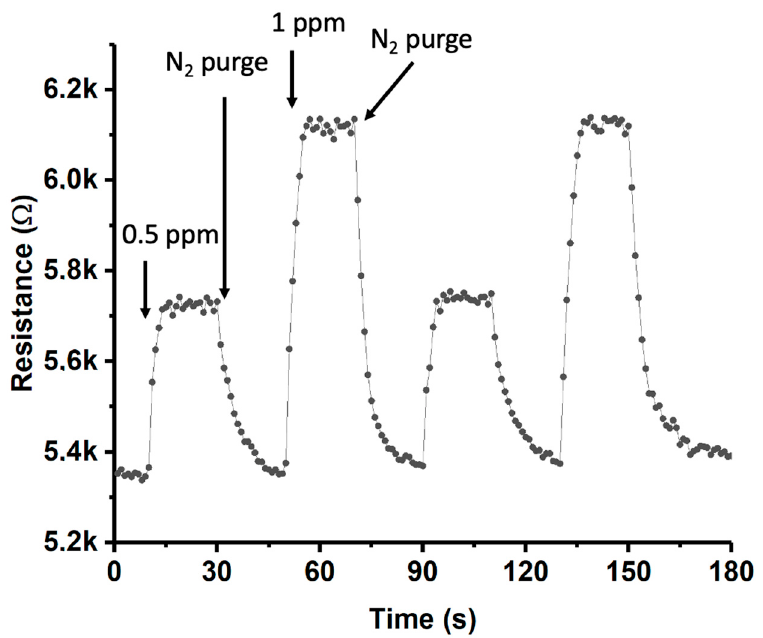
Figure 12. Dynamic response curves for the MoS 2 -Au(sputtering)-SWCNT composite gas sensor towards alternating exposure to NH 3 (0.5 ppm and 1 ppm) at 140 °C.